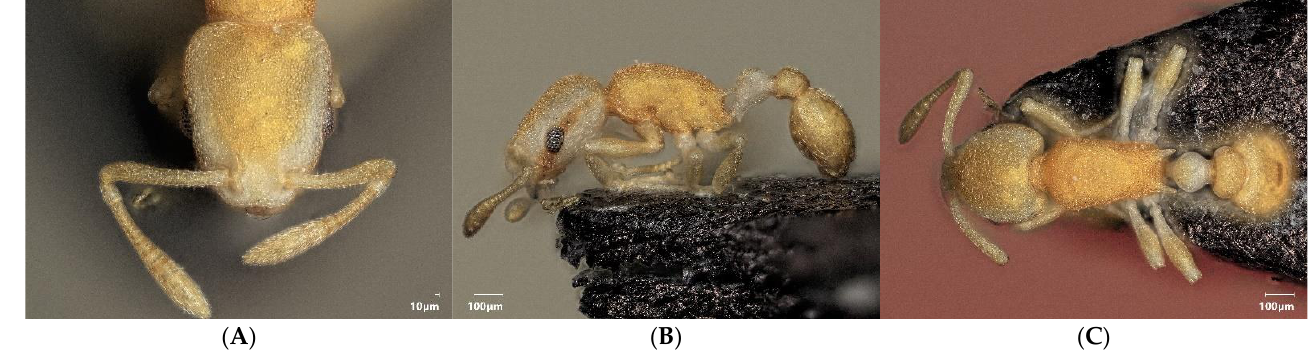
Figure 15. Cardiocondyla pirata holotype: head in dorsal view ( A ), lateral view ( B ), dorsal view ( C ).